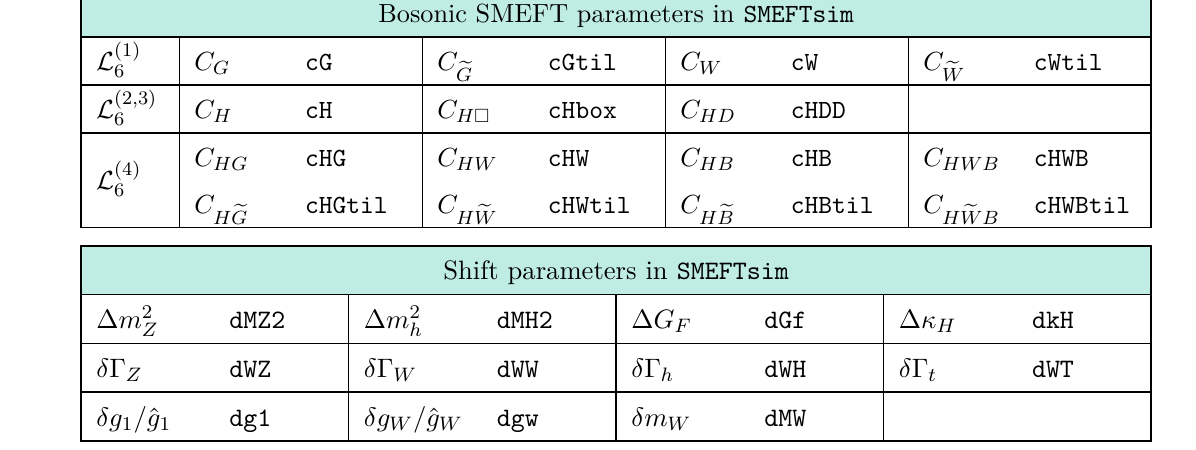
Table 16 . Common external parameters defined in all models, with the corresponding name in the code and default numerical value. The latter have been updated compared to previous SMEFTsim versions, according to the references indicated.